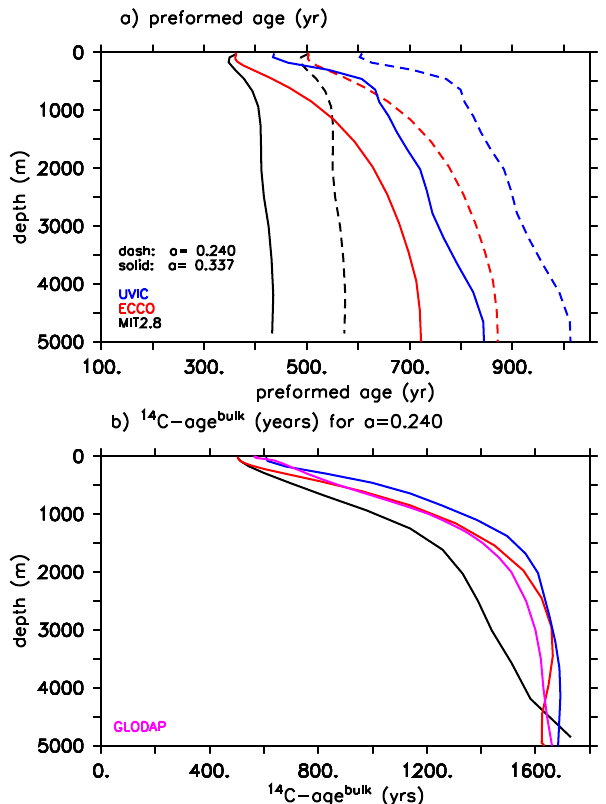
Figure 7. Sensitivity of preformed and bulk 14 C-age to the choice of the gas-exchange parameter a of Eq. (1). Panel (a) preformed 14 C-age for a = 0 . 337 (solid lines) and a = 0 . 24 (dashed lines). Re- sults from MIT2.8 (black), ECCO (red) and UVIC (blue) are shown. (b) Global mean profiles of 14 C-age bulk using a = 0 .